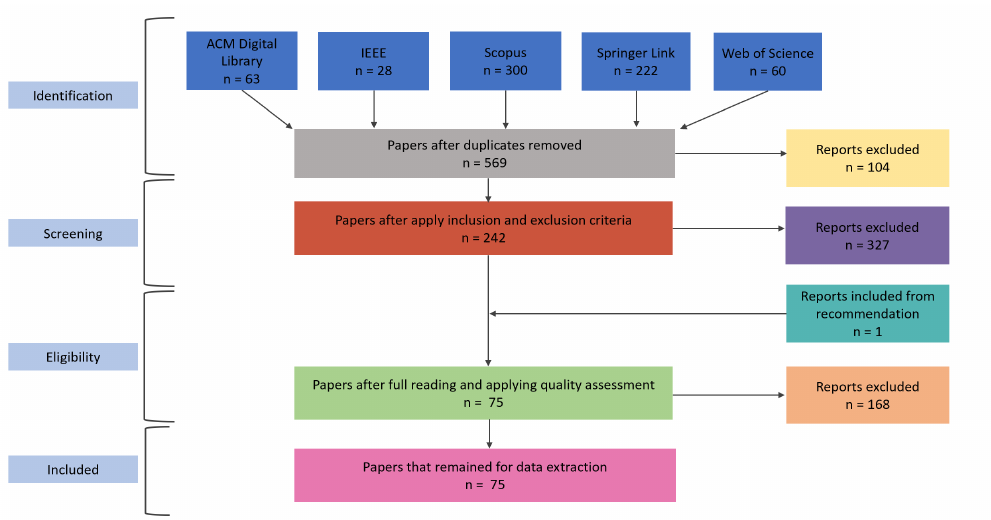
Figure 2. Results of conducting the review process. Source: Author.